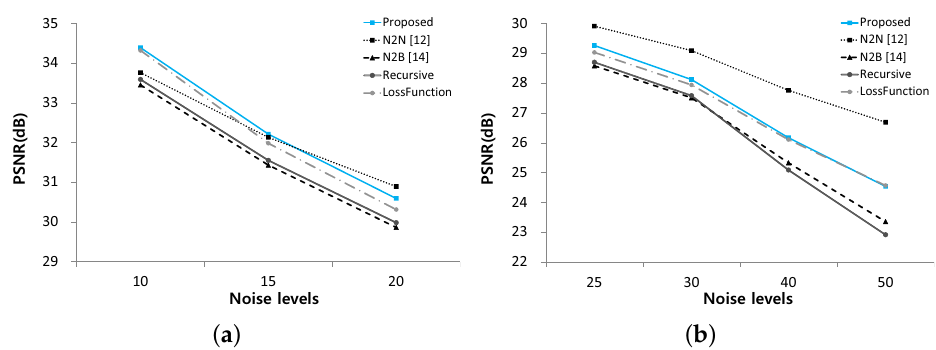
Figure 3. Comparison of denoising performance among N2N, N2B and proposed methods. ( a ) Noise levels from 10 to 20. ( b ) Noise levels from 25 to 50.